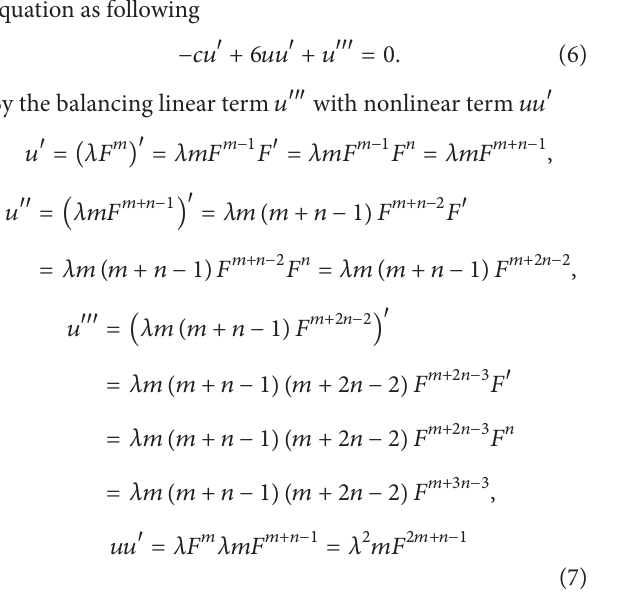
Example 1. For the KdV equation with the transform 𝑢(𝑥, 𝑡) = 𝑢(𝜉) , 𝜉 = 𝑥 − 𝑐𝑡 we have the ordinary differential equation as